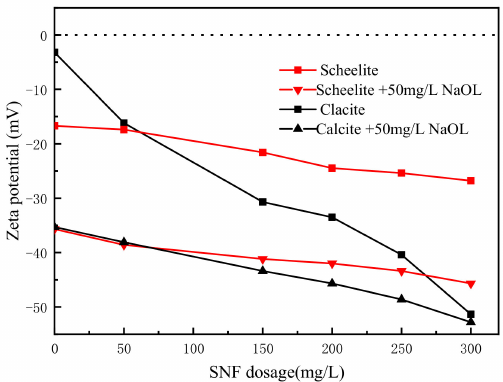
Figure 8. Zeta potentials of scheelite and calcite as functions of the SNF dosage in the presence and absence of 50 mg/L NaOL at pH